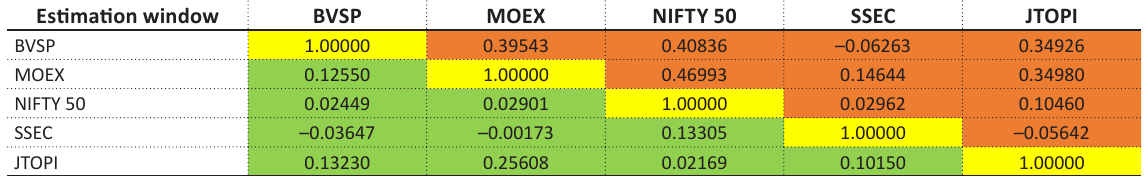
Table 10. Correlation matrix of BRICS nations in the estimation period and event window